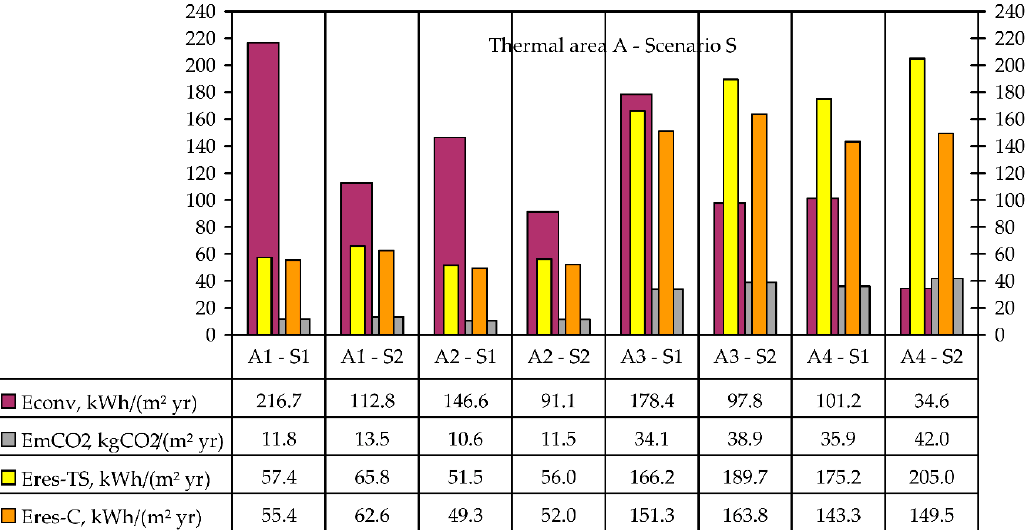
Table 11. Areas A 1 –A 4 . Specific indicators.